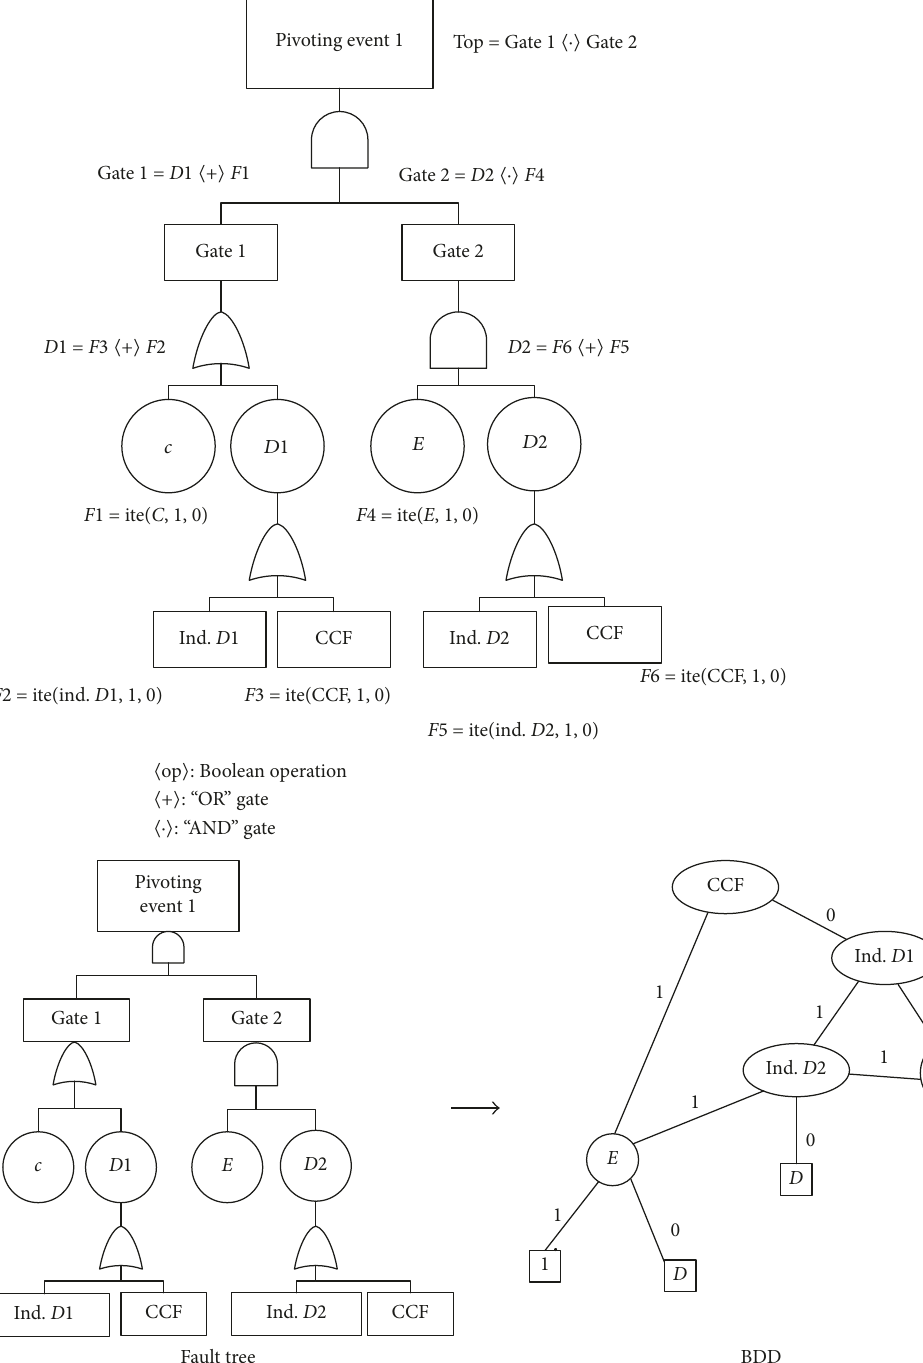
Figure 7: Conversion of fault tree to